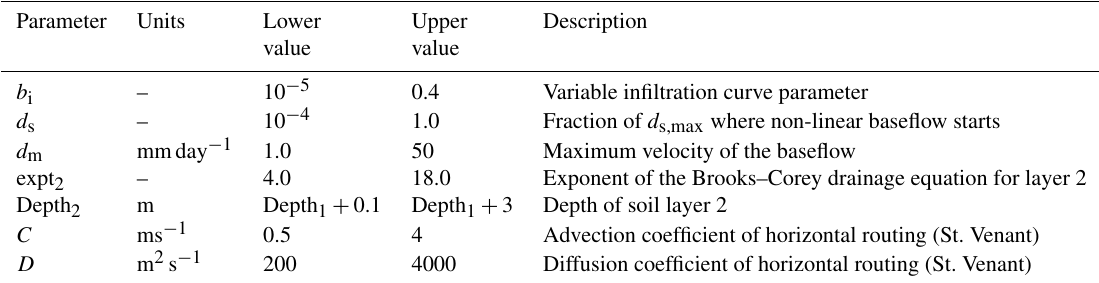
Table 1. Sampled model parameters. Parameter Units Lower Upper